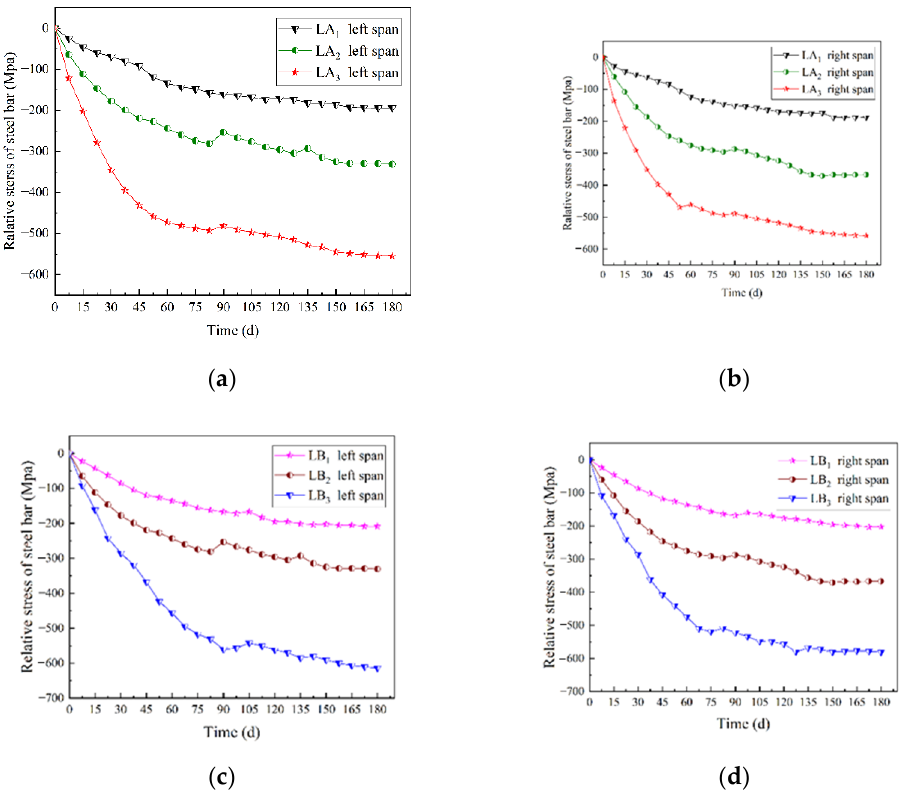
Figure 9. Time-varying curve of the relative stress of the steel wires. ( a ) Left span of group A (different steel wires quantities); ( b ) right span of group A (different steel wires quantities); ( c ) left span of group B (different prestress values); ( d ) right span of group B (different prestress values).